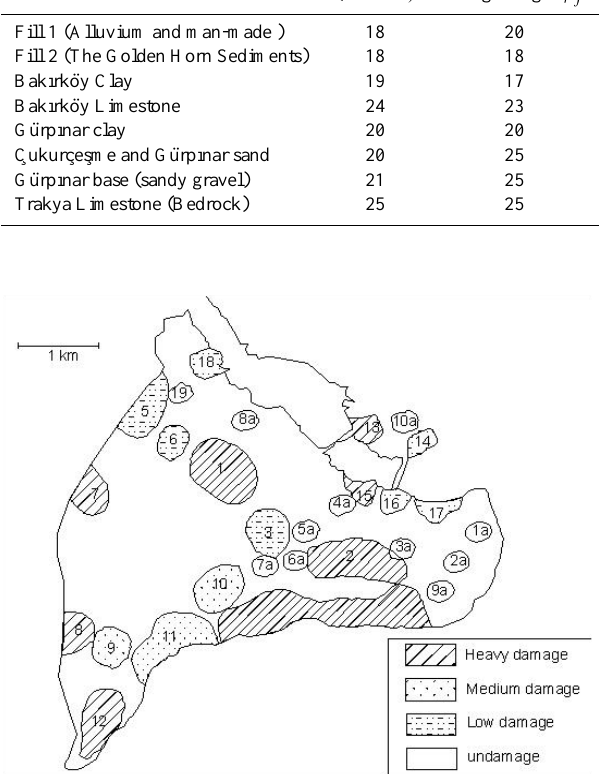
Figure 12. Comparison of the Regional Damage Map of 1894 Earthquake (Lav, 1994) and Fig. 12. Comparison of the Regional Damage Map of the 1894 landslide hazard microzonation map prepared for the probability of exceedance of 10% in 50 earthquake (Lav, 1994) and landslide hazard microzonation map years ( İ nce, 2005). prepared for the probability of exceedance of 10% in 50yr (˙Ince,